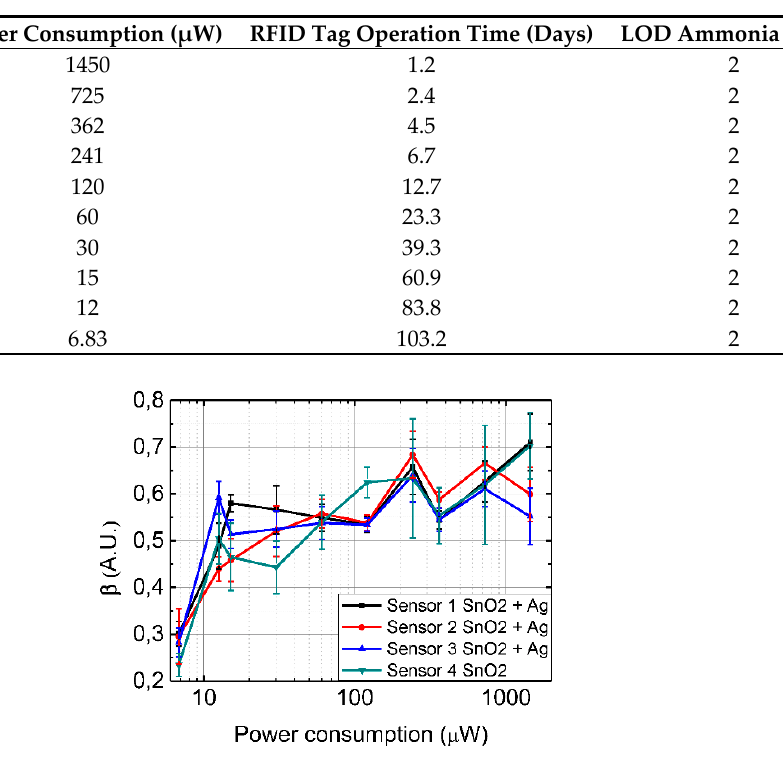
Table 1. Power consumption, battery life and LOD of ammonia as a function of the PTO mode.